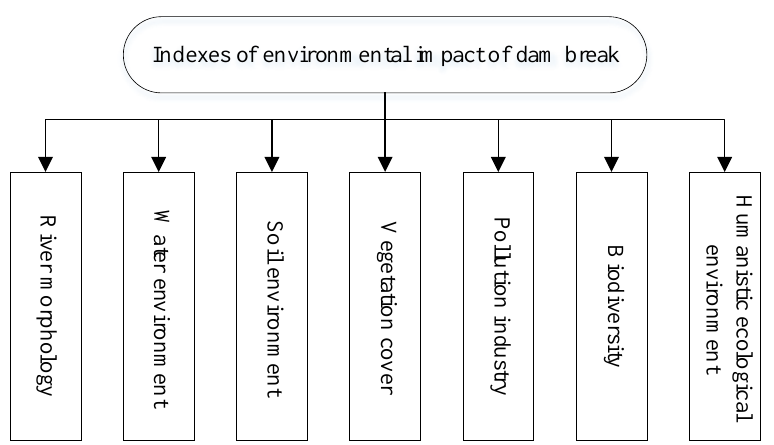
Figure 3. Index system of the environmental impact of dam break.